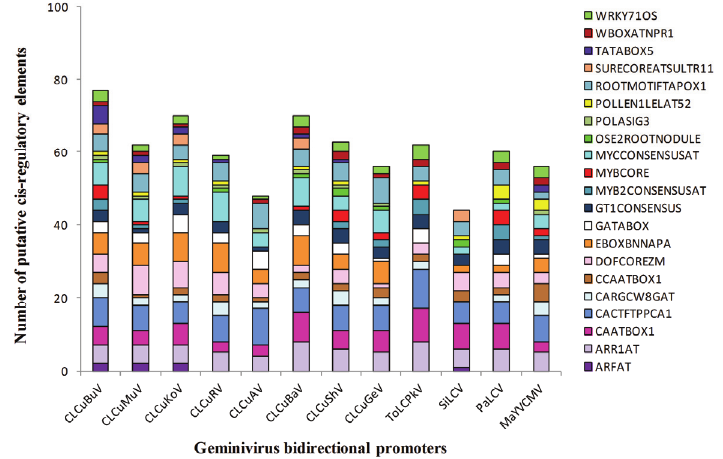
Figure 4. Occurrence of 21 enriched cis -acting regulatory DNA elements distributed in the 12 bidirectional geminivirus promoters.